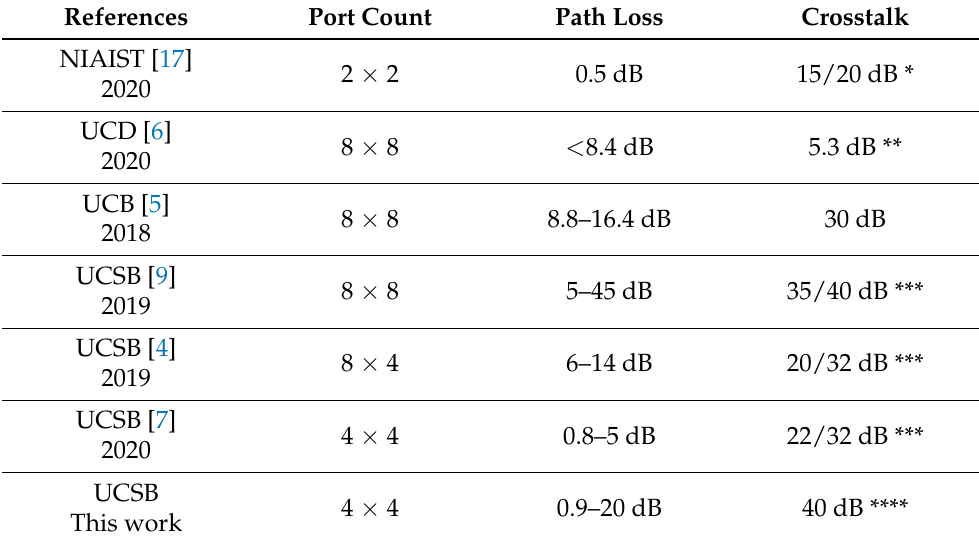
Table 1. Comparison with other notable silicon photonic multi-wavelength switches. * In- band/outband extinction. ** Worst case power penalty. *** Out of band rejection at 200 and 400 GHz. **** Out of band rejection at 400